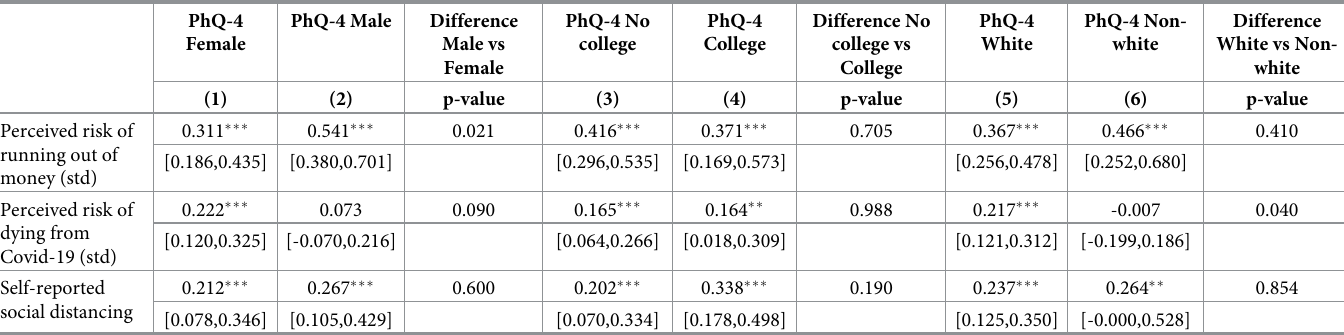
Table 4. Associations with mental health score